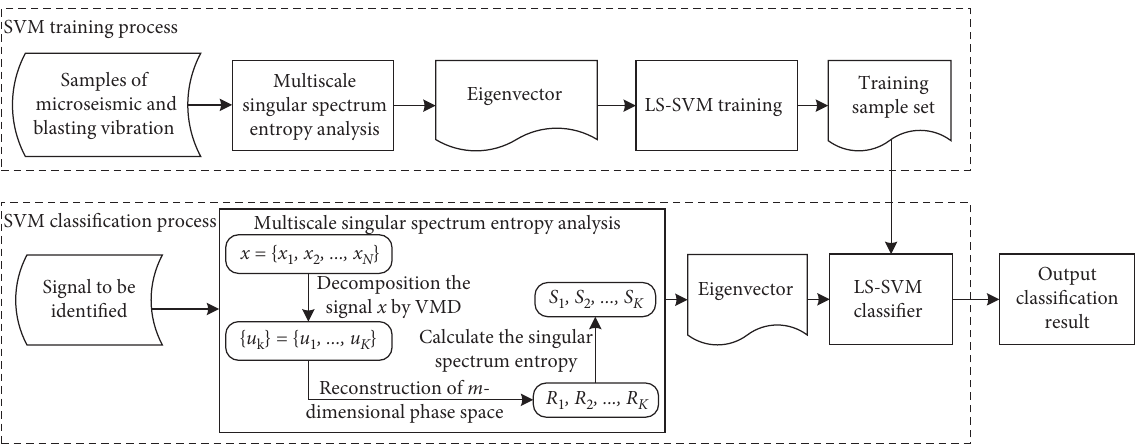
Figure 2: Signal identification flowchart.